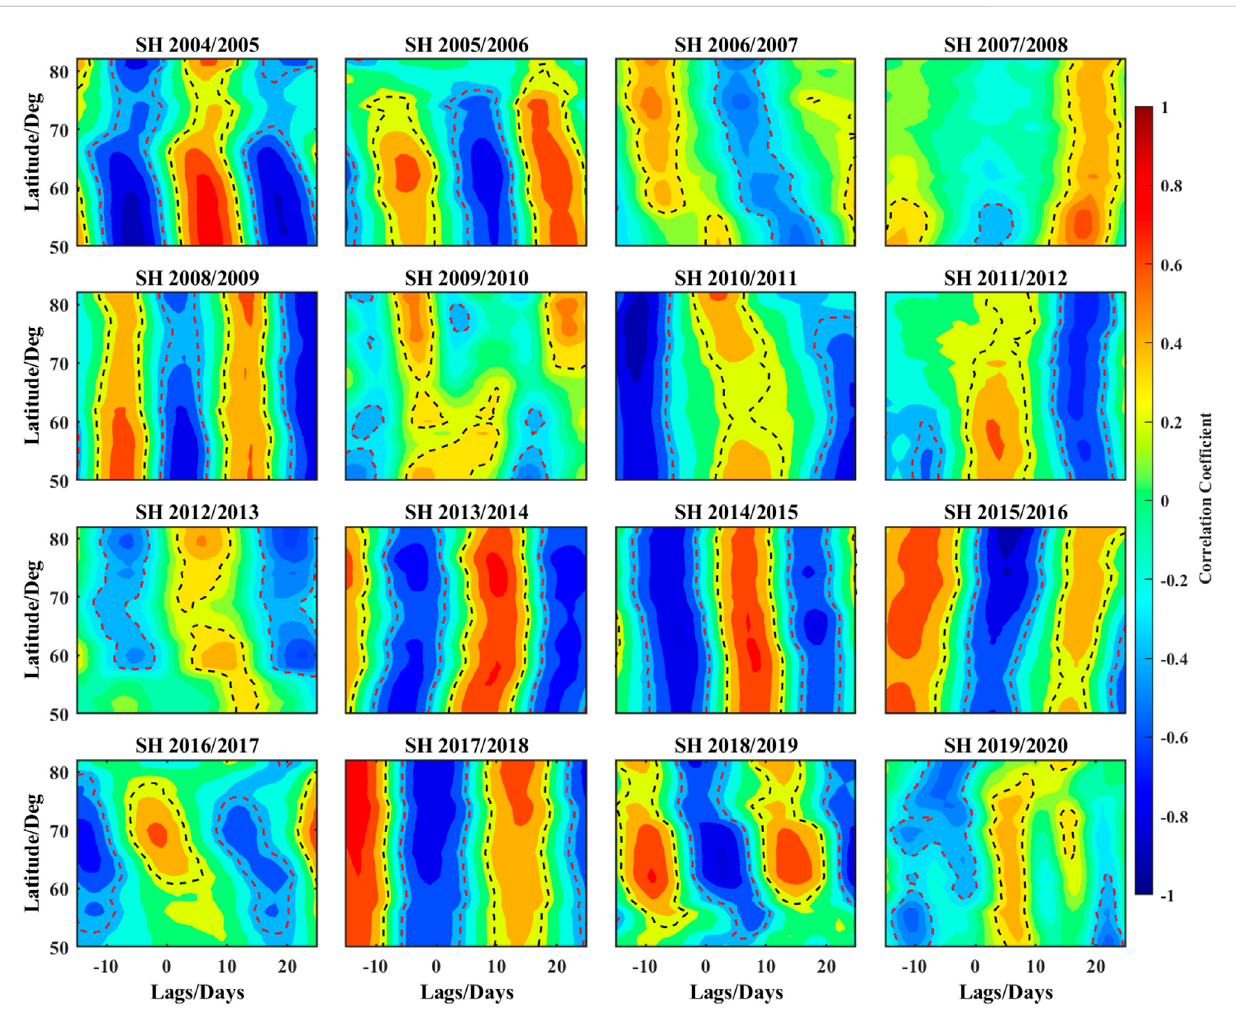
Correlation between the temperature and Y10 anomalies at 0.46 Pa over different latitudes, for the SH PMCs seasons during 2005 – 2020. The temperature data from MLS is averaged in the corresponding latitude. The red area surrounded by black dashed lines indicates that the signi fi cance level of the positive correlation between temperature and Y10 is greater than 95%. The blue area surrounded by the red dotted line indicates that the signi fi cance level of the negative correlation between temperature and Y10 is greater than